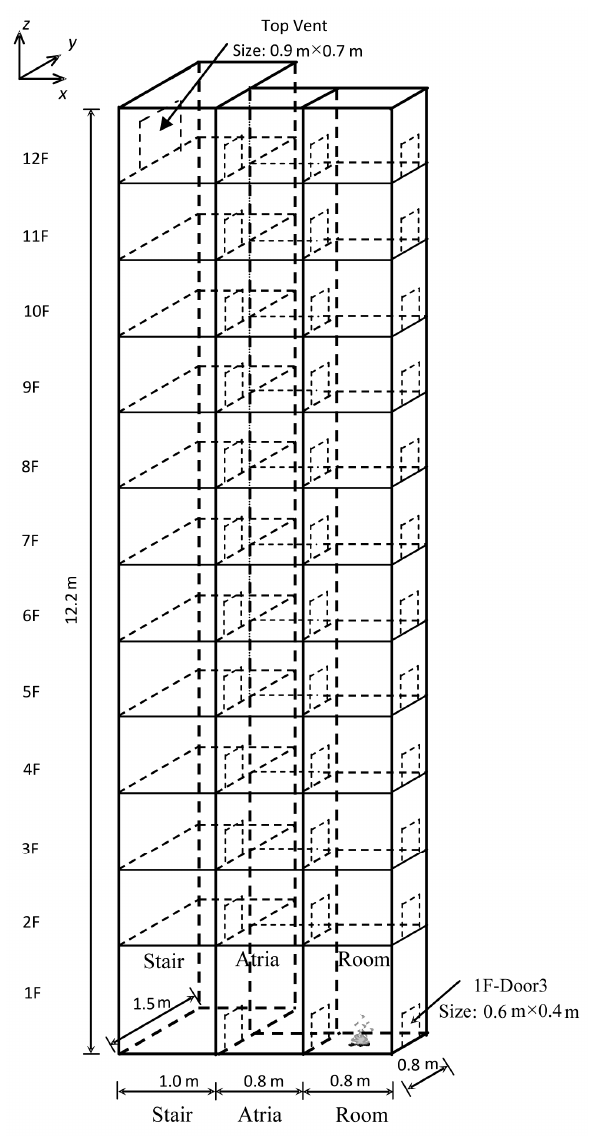
Fig. 1. Schematic of 12-layer-stairwell